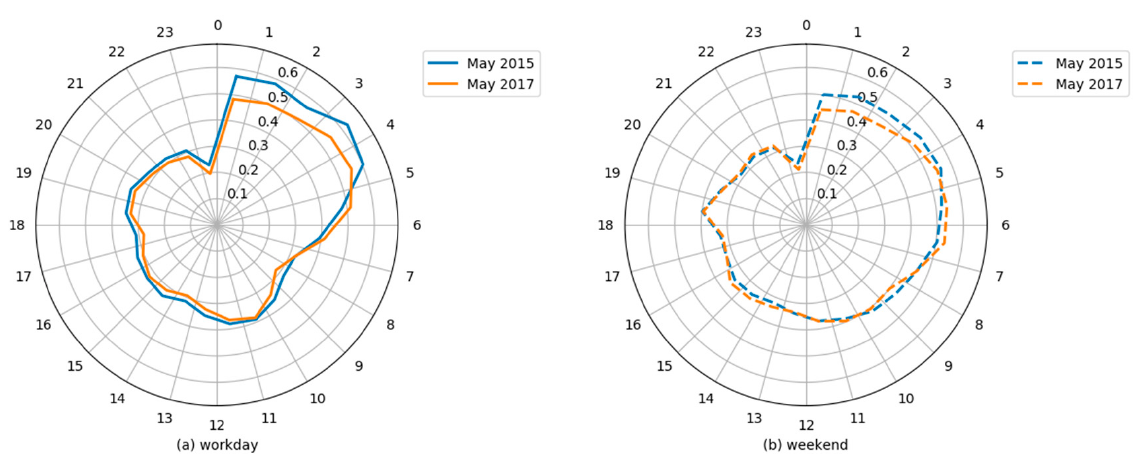
Figure 12. Unoccupied ratio ( a ) on workdays and ( b ) on weekends.